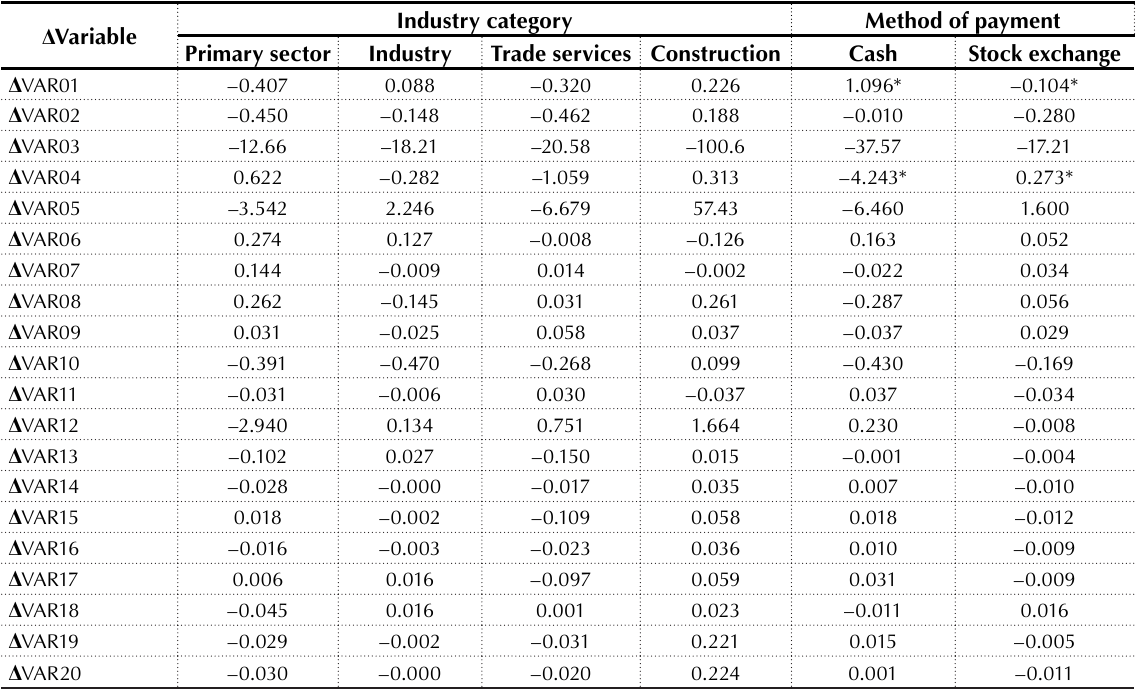
Table 6. Results (Kruskal-Wallis test) by industry and cash or equity payments ( H4 - H5